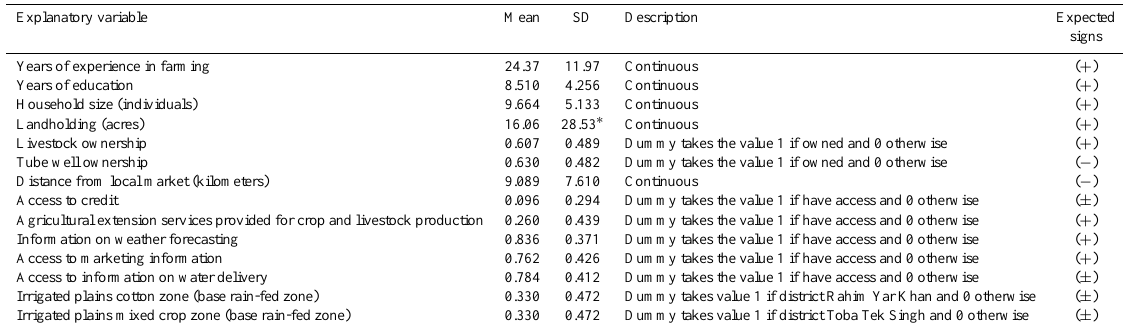
Table 2. Description of explanatory variables used in the